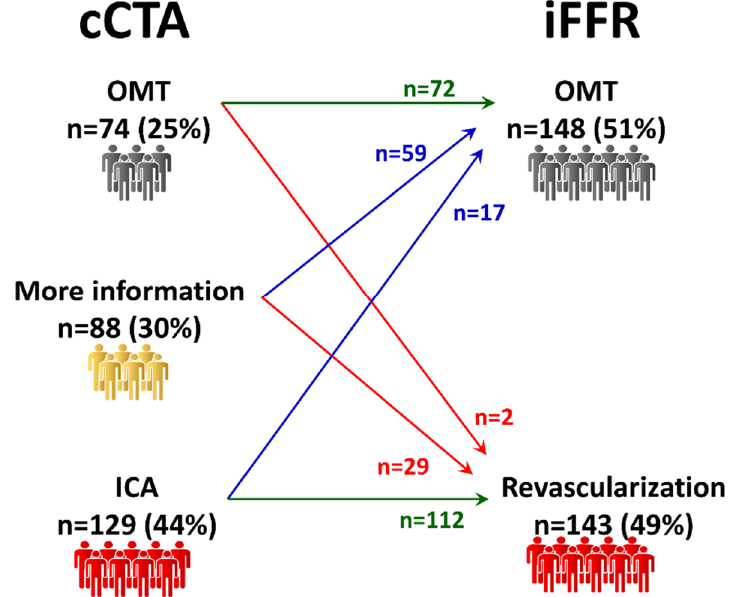
Figure 2. Management according to cCTA alone. Nearly one third of the population needed further assessment to be allocated to OMT or revascularization. cCTA: coronary computed tomography angiography; OMT: optimal medical treatment; ICA: invasive coronary angiography; iFFR: invasive fractional flow reserve.